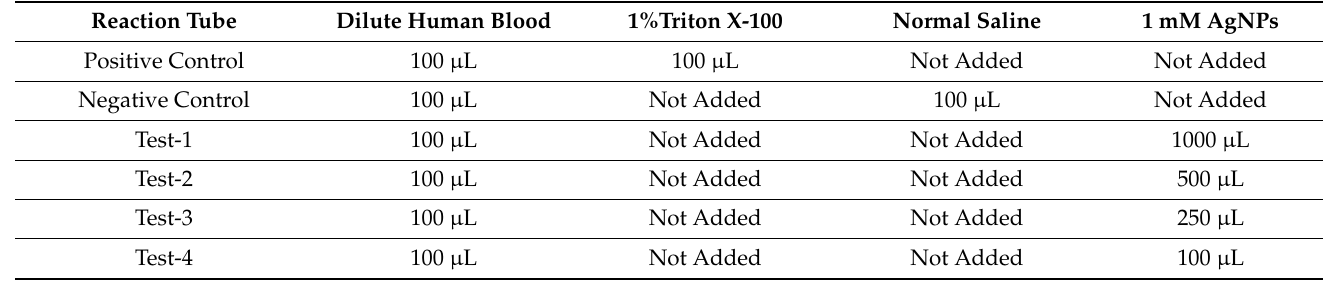
Table 1. Hemolytic activity of the AgNPs using healthy volunteer